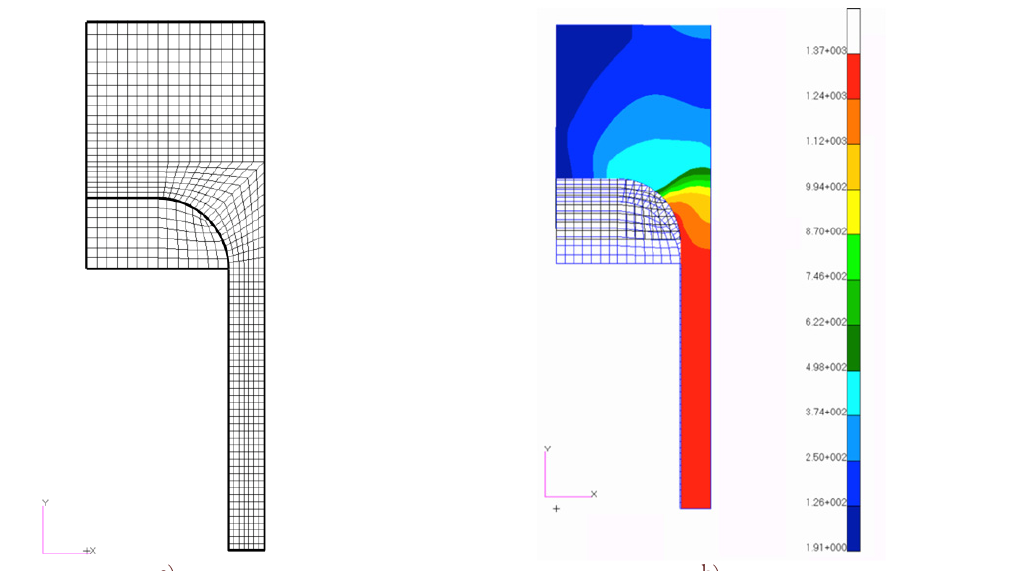
Figure 5: FE analysis of the testing condition: a) FE model and b) equivalent stress fringes at the maximum elongation.